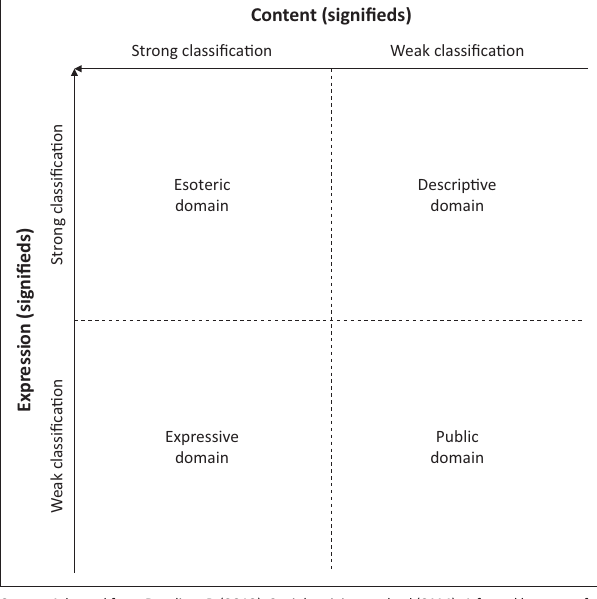
FIGURE 1: Dowling’s domains of mathematical